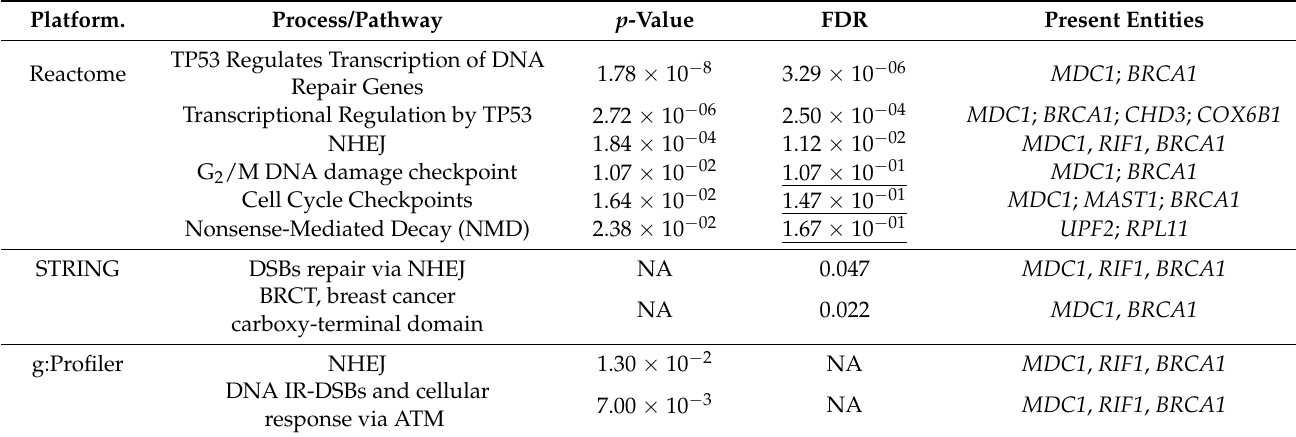
Table 3. Significantly overrepresented pathways identified via Reactome, STRING and g:Profiler using differentially expressed protein in the MCF7 cells treated with the synergistic AP-1 and DOX combination.